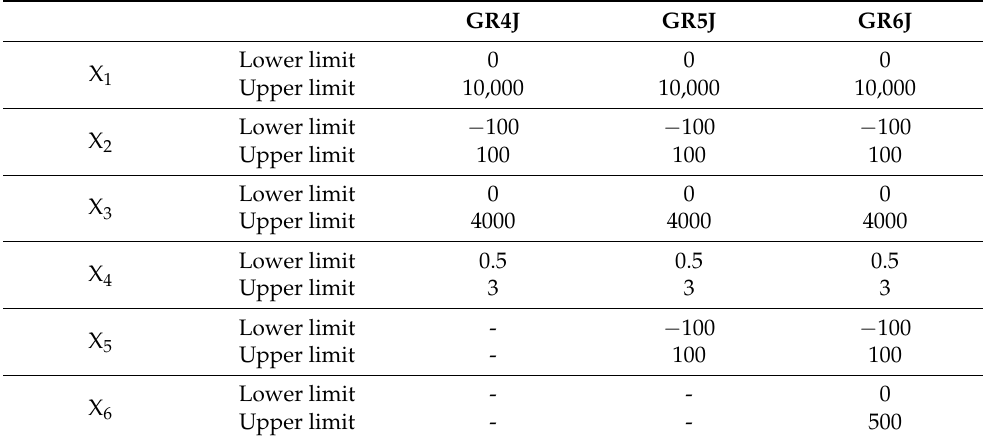
Table 6. Low and upper limit of the parameters of the GR4J, GR5J and GR6J hydrological models for the sensitivity